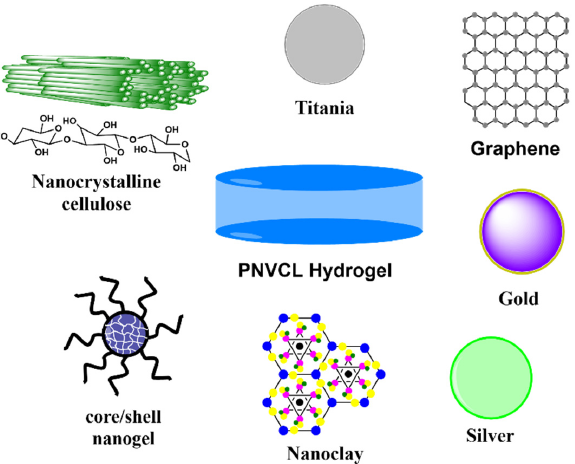
Figure 4. Types of fillers used for the preparation of PNVCL composites hydrogels in the last dec-